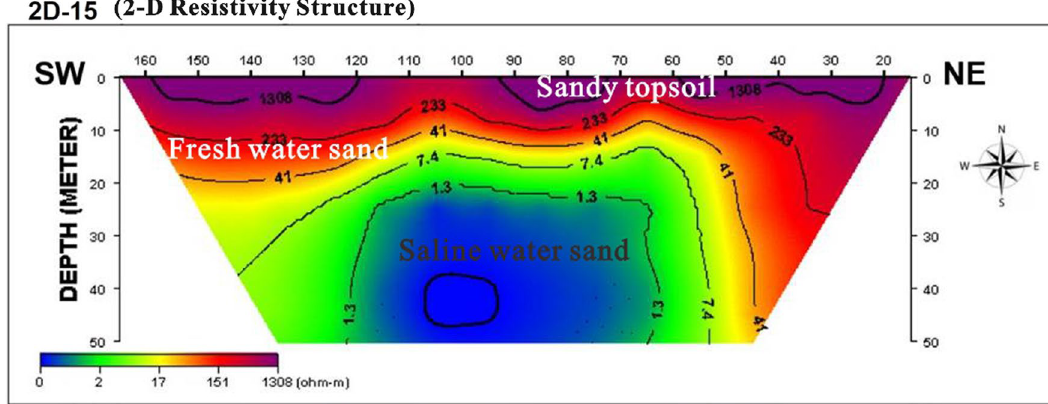
Fig. 19 Resistivity imagining of Traverse